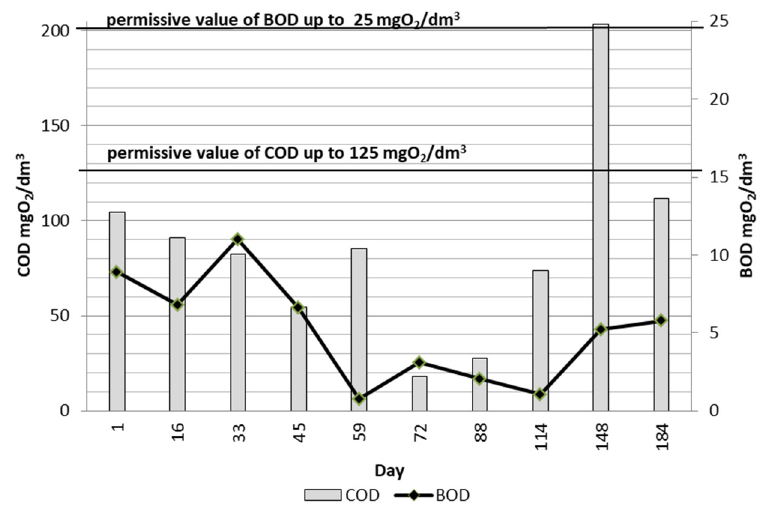
Figure 6. Changes in COD and BOD concentrations in treated wastewater from the 1st to the 184th 184th day of operation (April–October day of operation (April–October 2021).